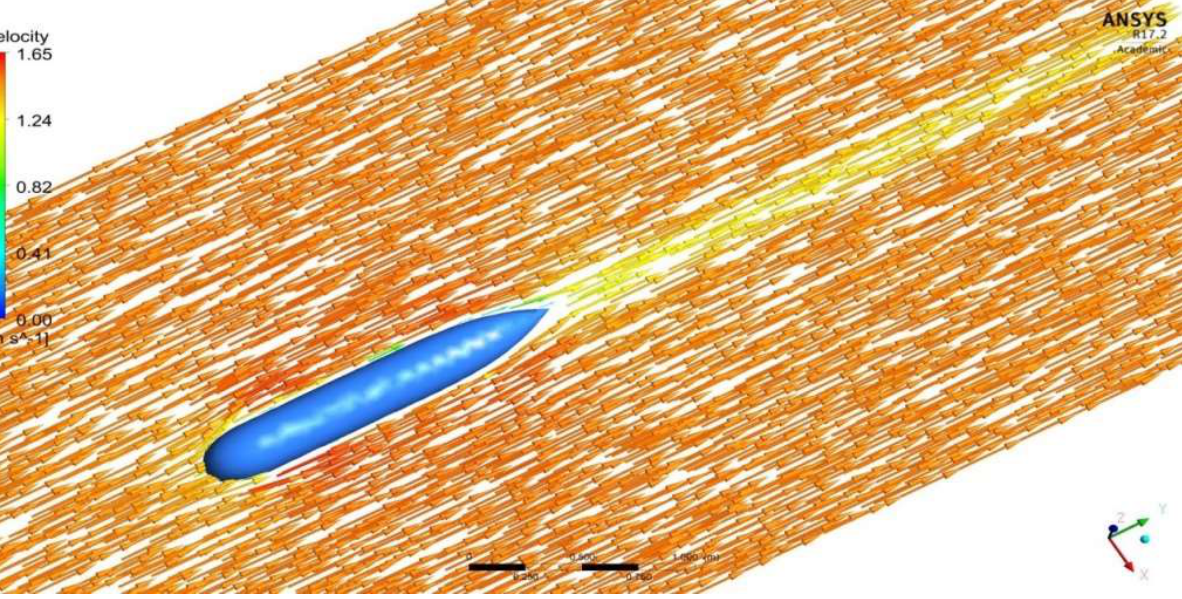
Figure 13. Velocity Variation on the Fuselage model—Isometric view.